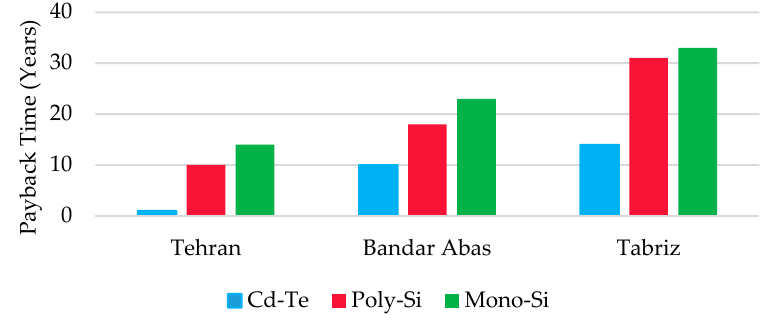
Figure 4. Comparing payback time of Cd-Te, Poly-Si and Mono-Si in Tehran, Bandar Abas and